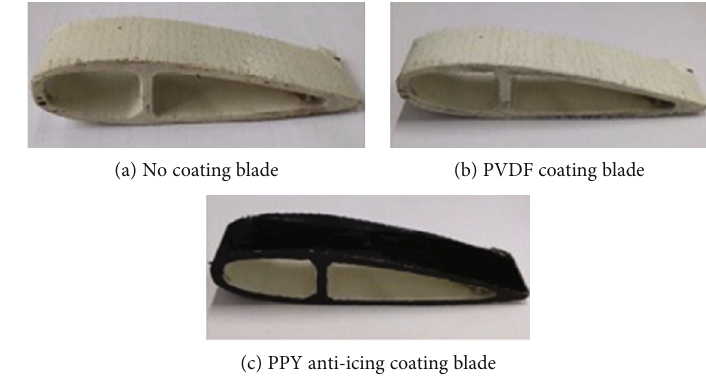
Figure 2: Blade model.